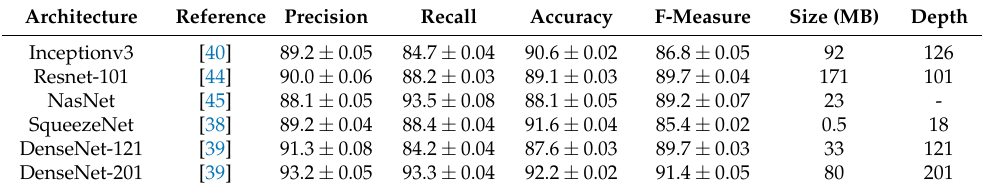
Table 2. Comparison of the main architectures in the literature.